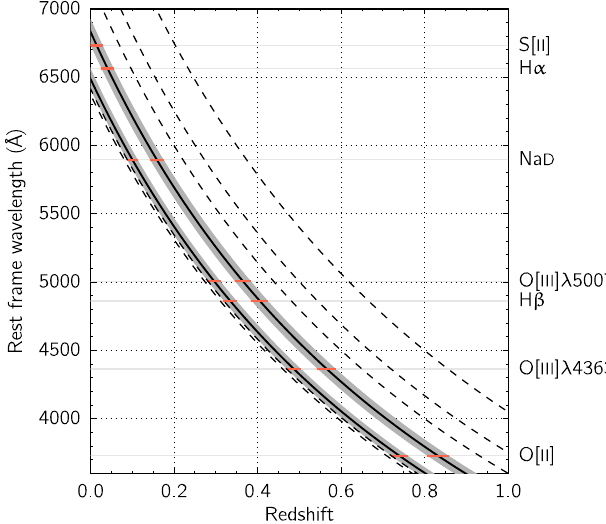
FIG. 8. Spectral region — in the rest frame of an astrophysical source — affected by laser-induced Raman contamination as a ¼ 589 nm. For both O function of redshift, assuming λ 2 and LGS N 2 molecules, the greyed-out zone marks the spectral extent of the rotational sidelines out to J ¼ 17 . The redshift zones associated with a few important optical lines are highlighted in red. Spectral regions affected by the (3 – 4 orders of magnitude fainter) Raman contamination from CO 2 molecules, H 2 O mol- ecules, and the first overtone of O 2 molecules and N 2 molecules are indicated with dashed-dotted